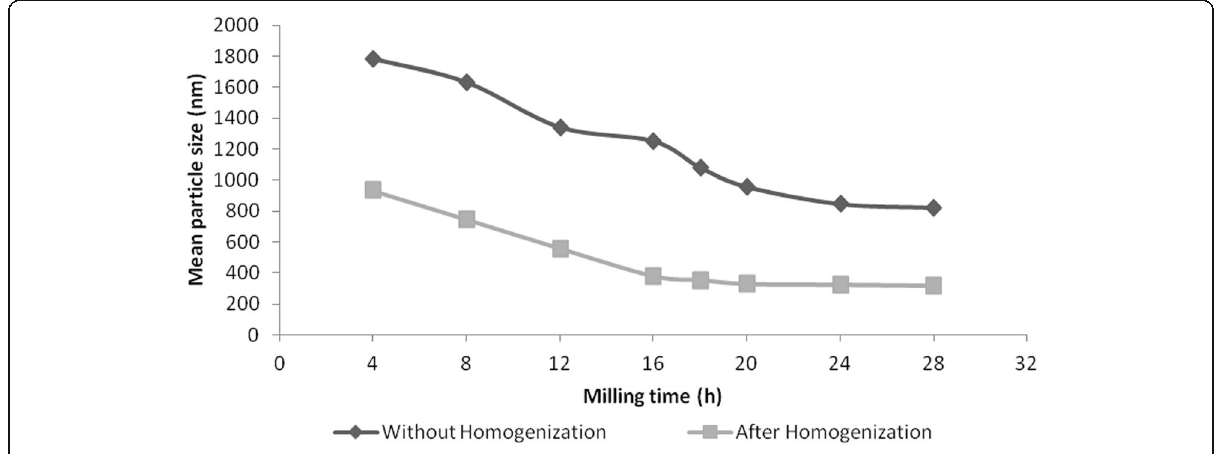
Fig. 3 Effect of milling time and amount of beads on mean particle